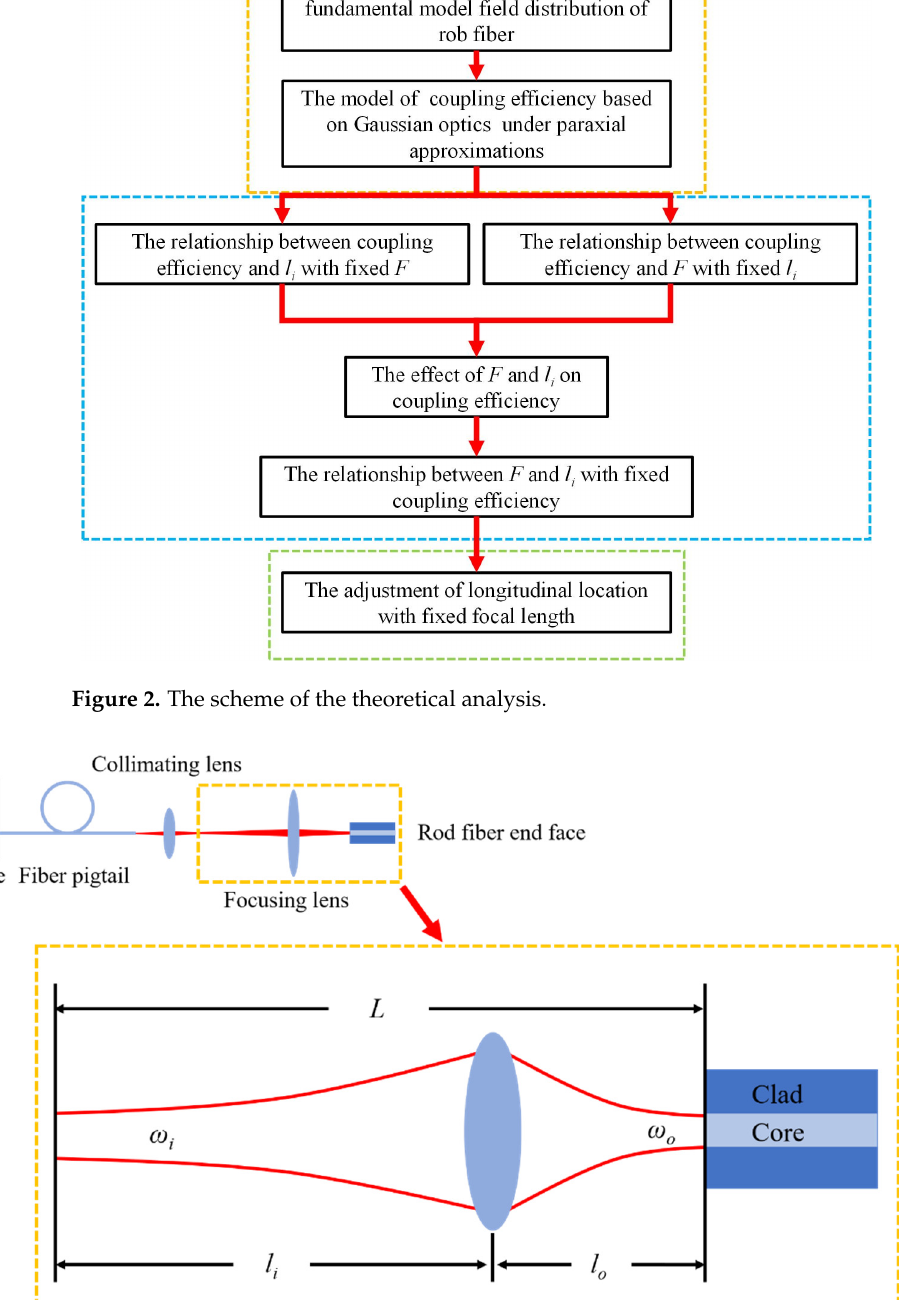
Figure 3. The scheme of lens coupling.